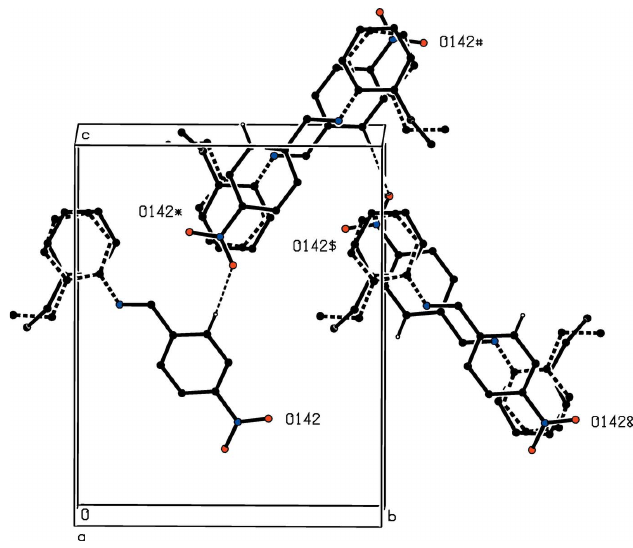
Figure 4 Part of the crystal structure of compound (I) showing the formation of a chain parallel to the [010] direction built from alternating C—H (cid:2)(cid:2)(cid:2) O hydrogen bonds and nitro (cid:2)(cid:2)(cid:2) (cid:2) (arene) interactions. For the sake of clarity, the H atoms not involved in the motif shown have been omitted. The atoms marked with an asterisk (*), a hash (#), a dollar sign ($) or an (cid:5) x , 1 (cid:5) y , 1 ampersand (&) are at the symmetry positions ( 3 + z ), (1 (cid:5) x , 2 2 1 (cid:5) z ), ( (cid:5) 1 (cid:5) y , 1 (cid:5) z ) and ( x , 1 + y , z ), respectively. For the + y , 3 + x , 3 2 2 2 2 disordered 2-ethylphenyl group, the major component is drawn using solid lines and the minor component is drawn using dashed lines.